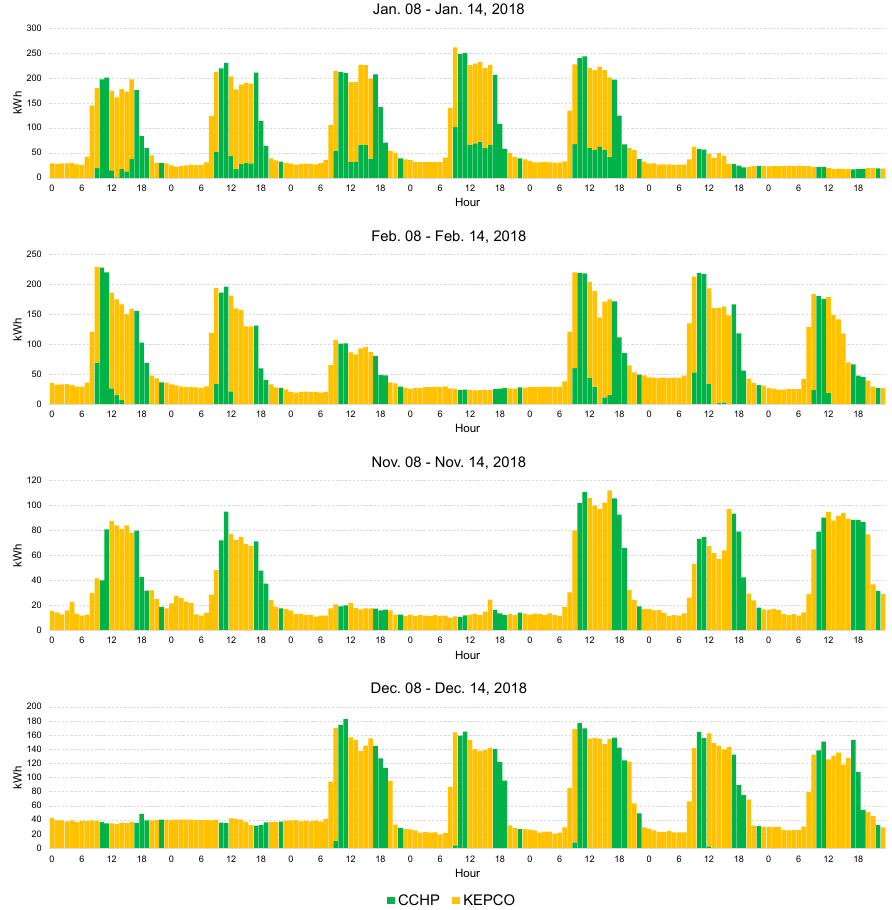
Energies 2020 , 13 , x FOR PEER REVIEW Figure 8. Example of CCHP operation scheduling in winter. Figure 8. Example of CCHP operation scheduling in winter.